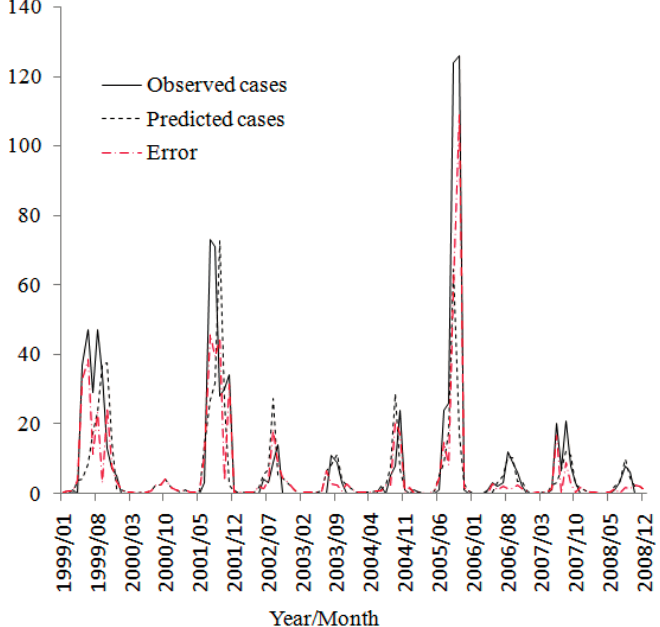
Figure 7. Observed cholera cases and predicted cases of fitted